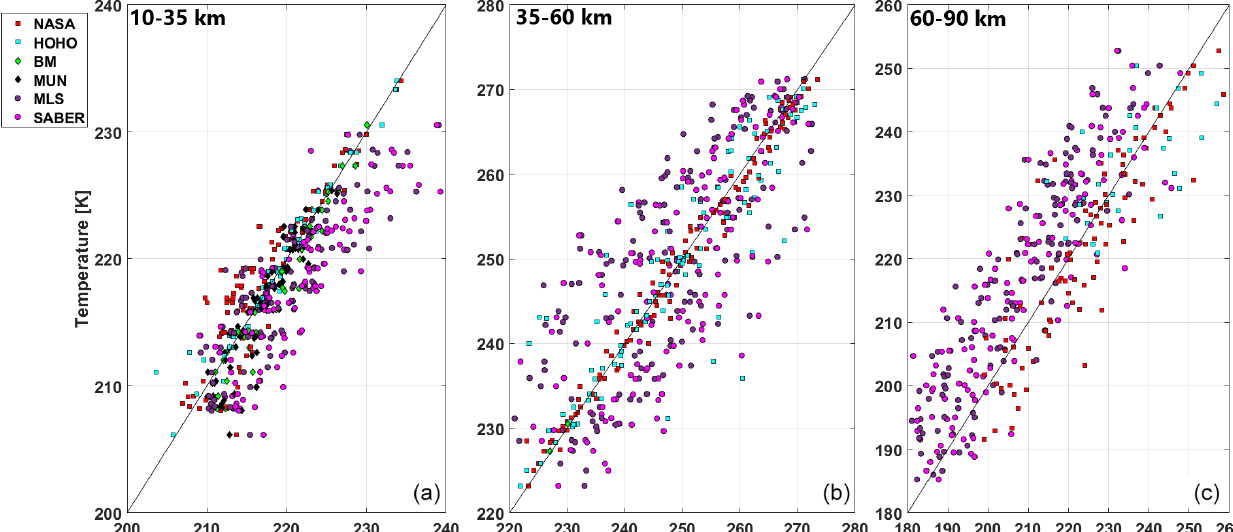
Figure 11. Scatter plots of temperature at 2km resolution for the different instruments involved in the HOPS campaign with respect to the HOH lidar: (a) 10 to 35km; (b) 35 to 60km; (c) 60 to 90km.